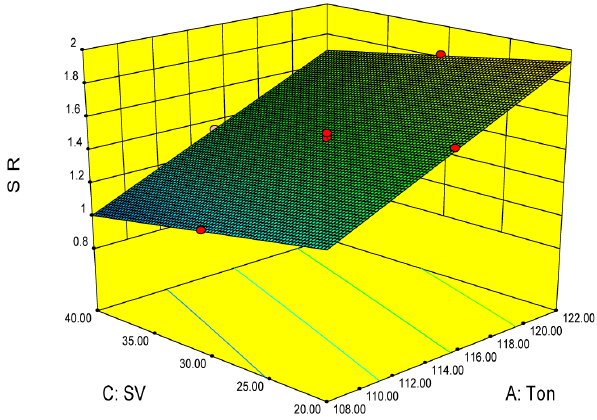
Figure 8a. Combined e ff ects of T on and T o ff on